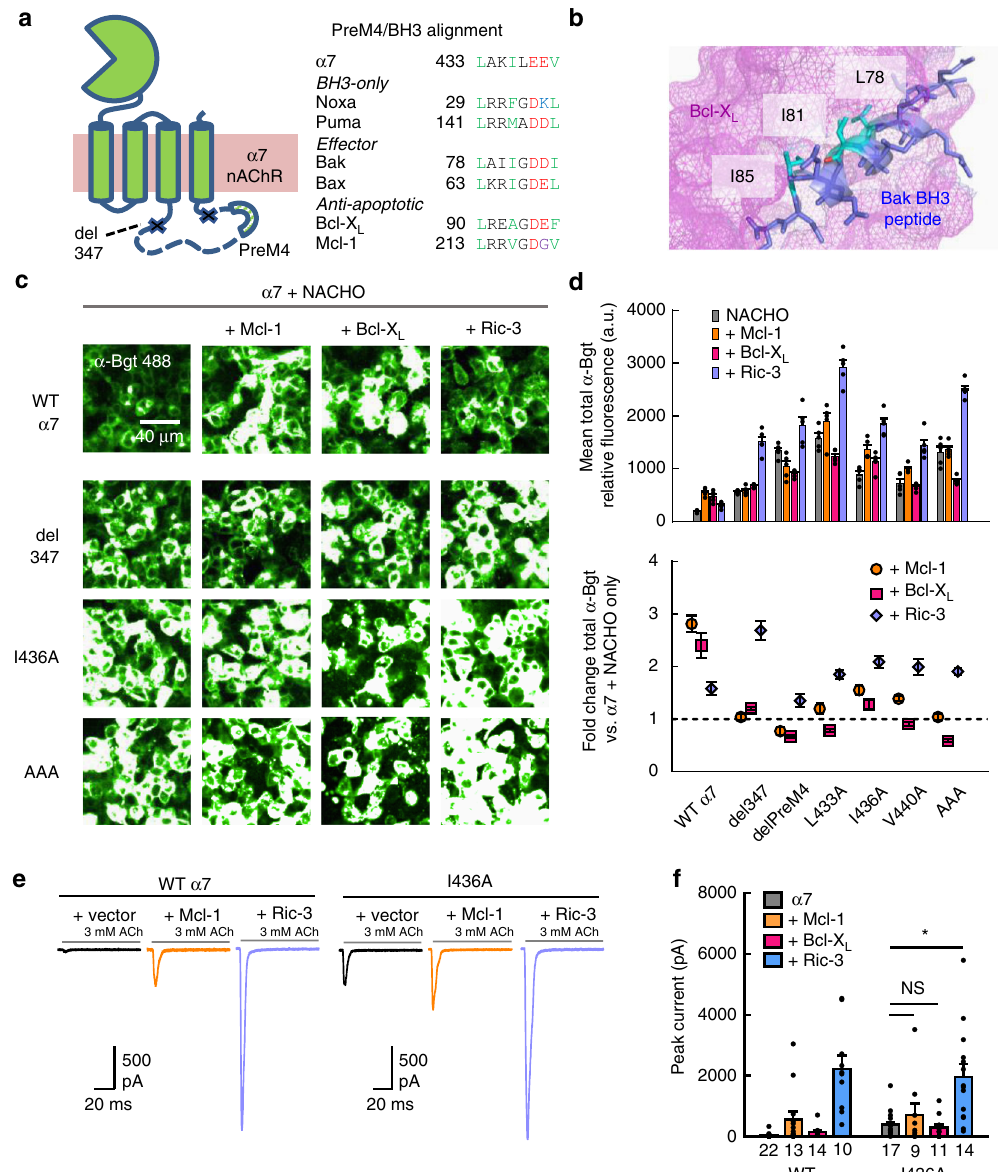
Fig. 4 Mutations in a BH3-like motif of α 7 nAChRs attenuate Bcl-2-mediated upregulation. a Cartoon illustration of α 7 nAChR topology, including the region removed in the del 347 mutant and location of the pre-M4 helix (left). Also shown is a sequence alignment between the pre-M4 helix and BH3 domains of several Bcl-2 family proteins (right), color-coded by hydrophobicity, where hydrophobic (green), acidic (red), and basic (blue) residues at key positions are indicated. b Structure of Bcl-X L bound by the BH3 segment of Bak (PDB: 1BXL 31 ) with hydrophobic residues on Bak mediating the interaction highlighted (teal). c Fluorescent α -Bgt labeling of permeabilized HEK293T cells cotransfected with cDNAs encoding wild-type or mutant α 7 and NACHO, along with other proteins, at a 1:3:4 respective ratio. d Quanti fi cation of fl uorescence intensity from α 7 mutants labeled by α -Bgt (top) and the fold change in fl uorescence intensity relative to α 7 and NACHO expressed alone (bottom; n = 5). The fold effect of Mcl-1 and Bcl-X L coexpression was signi fi cantly reduced when comparing wild-type with mutant α 7 subunits ( p < 0.01), though Ric-3-mediated upregulation did not differ signi fi cantly for any mutant except del 347 (which was further enhanced). The same cDNA combinations were transfected at different passage numbers and yielded similar results. e Representative whole-cell current responses elicited from HEK293T cells transfected with cDNAs encoding wild-type or mutant α 7 receptors, alone or with Mcl-1, or Ric-3 at a 1:5 ( α 7: other) cDNA ratio. Cells were incubated 24 h at 30 °C prior to recording. f Summary graph of agonist-evoked peak currents for transfections described in panel ( e ) (* p < 0.01) with the n value for each condition indicated. Values for wild-type α 7 with Mcl-1 and Bcl-X L taken from data set in Fig. 2d. For the wild-type receptor, but not the I436A mutant ( p = 0.03, WT; p = 0.22, I436A; two-sample one-tail t test), Mcl-1 signi fi cantly increased peak currents. All data are means± SEM; p values from two-sample t